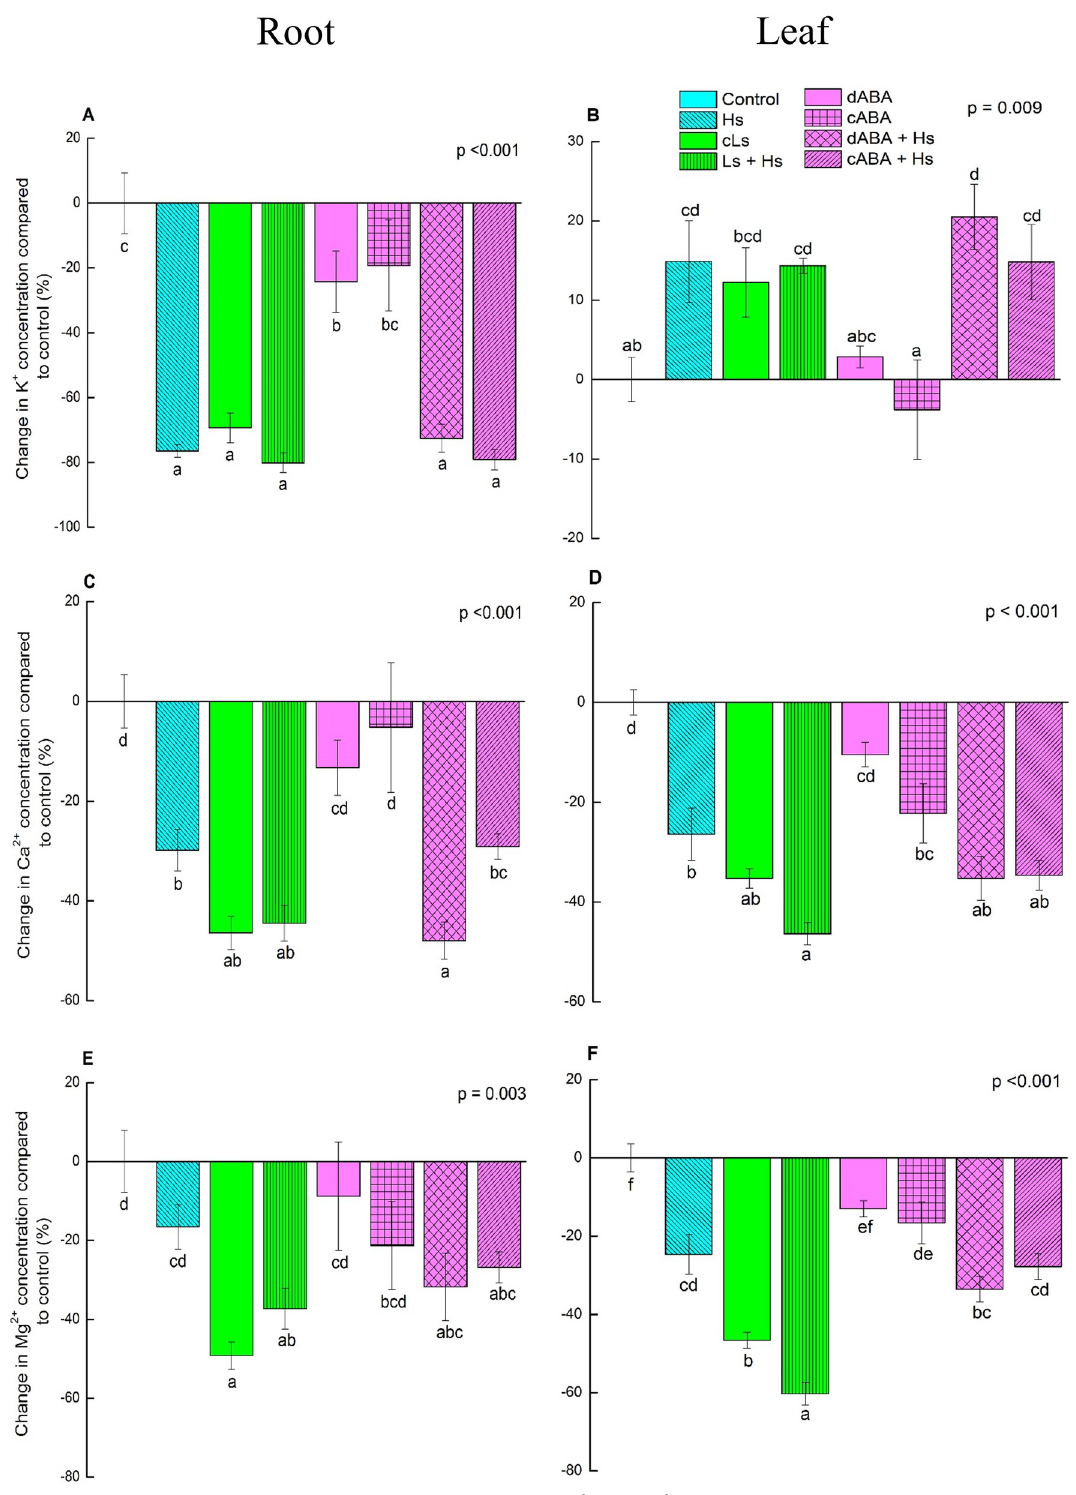
Fig 4. Changes in the concentration of most abundant cations (K + , Ca 2+ and Mg 2+ ) in root and leaf tissues in response to salinity and ABA. Graph A, C and E represent the changes in K + , Ca 2+ and Mg 2+ concentrations respectively compared to control in roots. Graph B, D and F represent the changes in K + , Ca 2+ and Mg 2+ concentrations respectively compared to control in leaves. In case of respective ion, mean value of controls was subtracted from each treatment value and then % change compared to control condition